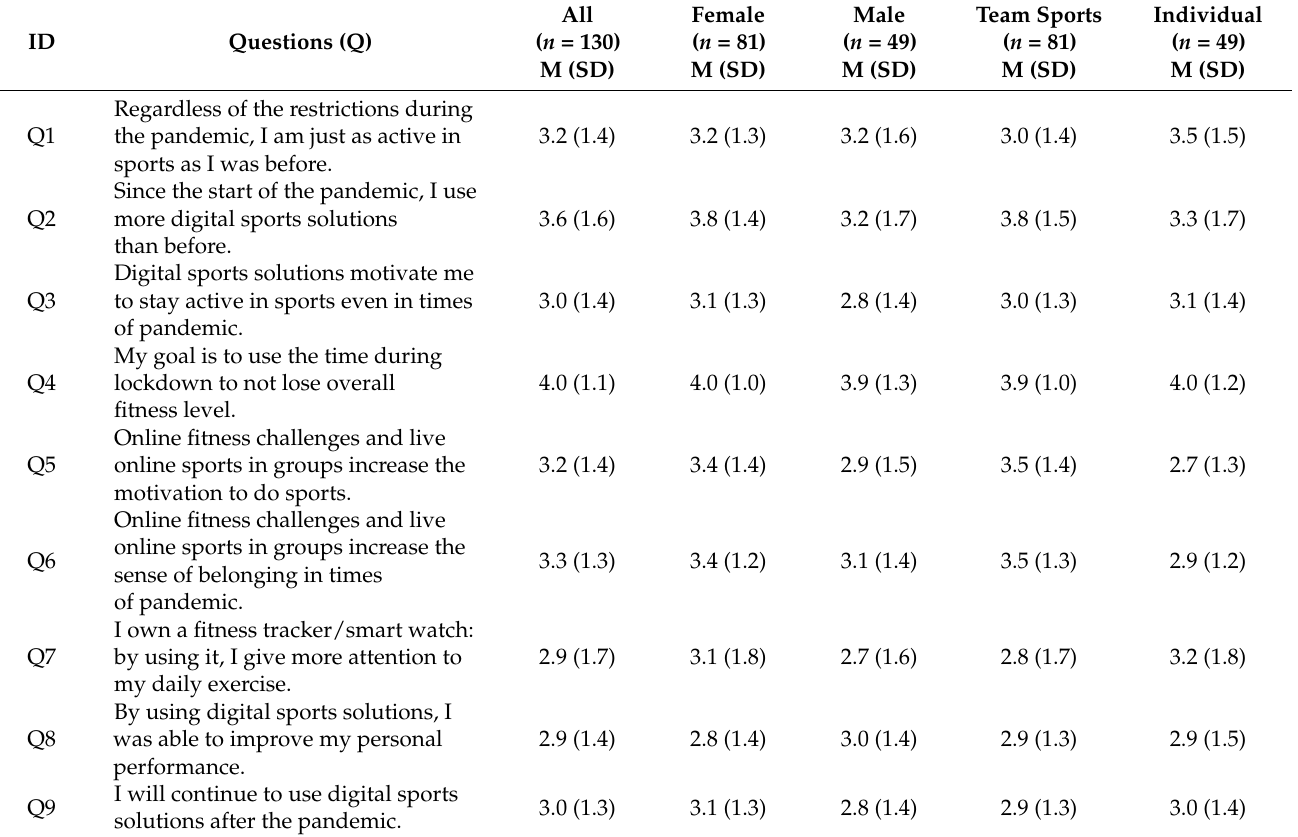
Table 3. Means and standard deviations for the questions of all, female, and male participants as well as participants preferring team sports versus participants preferring individual